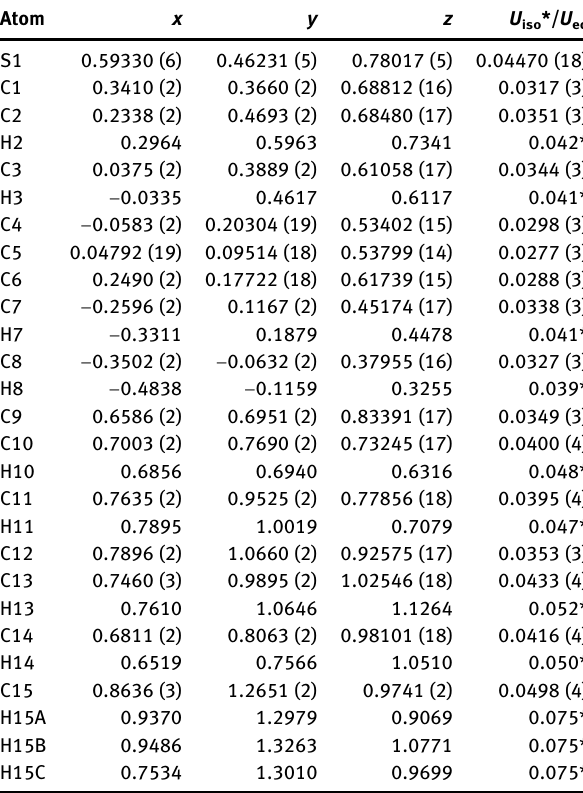
Table  : Fractional atomic coordinates and isotropic or equivalent isotropic displacement parameters (Å  ).